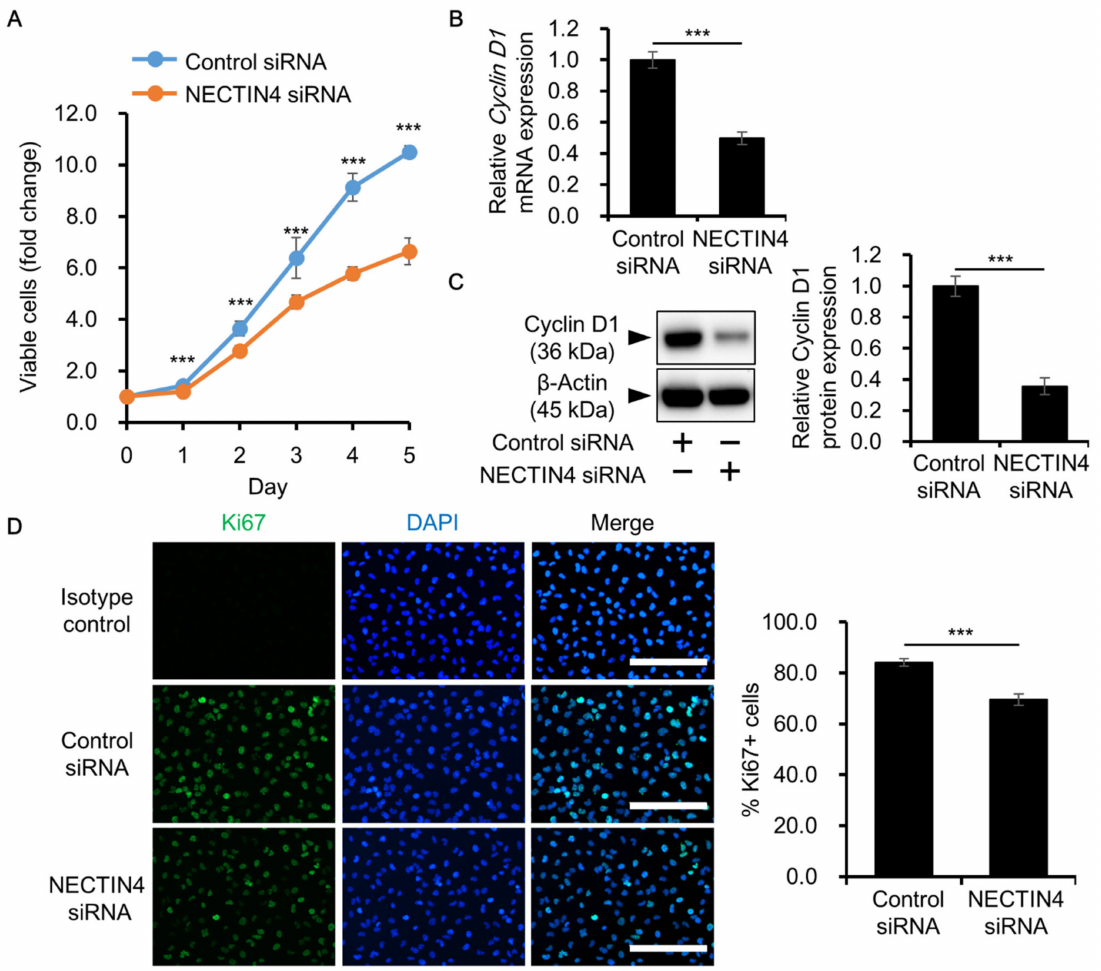
Figure 5. Effects of NECTIN4 inhibition on the proliferation of A431 cells. ( A ) Cells were transfected with control or NECTIN4 siRNA and cell viability was evaluated on days 1–5 after transfection using the CCK-8 cell viability assay. Experiments were independently repeated three times and performed in five wells per condition. *** p < 0.001. ( B , C ) Relative cyclin D1 expression at the mRNA ( B ) and protein ( C ) levels in control and NECTIN4 siRNA-transfected cells ( n = 3). *** p < 0.001. ( D ) Representative immunocytochemical images of Ki67 staining (left) and the percentage of Ki67-positive cells (right) in control and NECTIN4 siRNA-transfected cells. DAPI was used to detect cell nuclei. Three different areas per well were randomly selected and three independent wells were observed. Scale bars = 200 µ m. Data are presented as the mean ± SD. *** p <